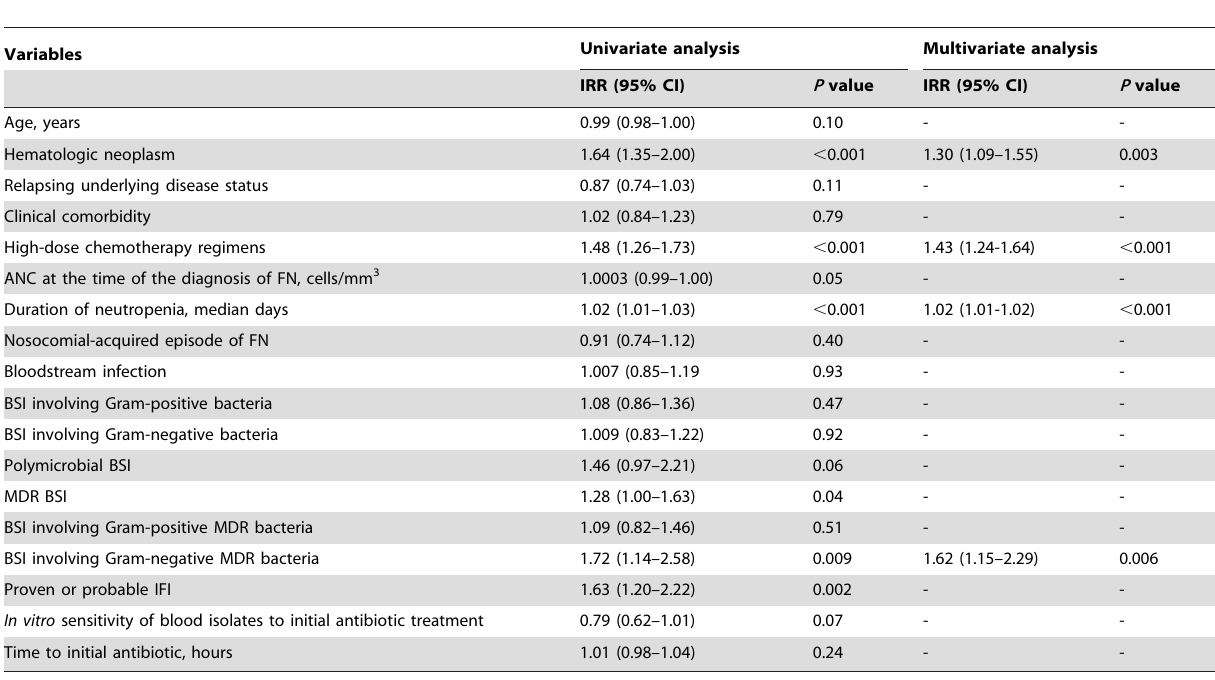
Table 2. Negative binomial regression of factors associated with hospital length of stay among cases of febrile neutropenia in cancer